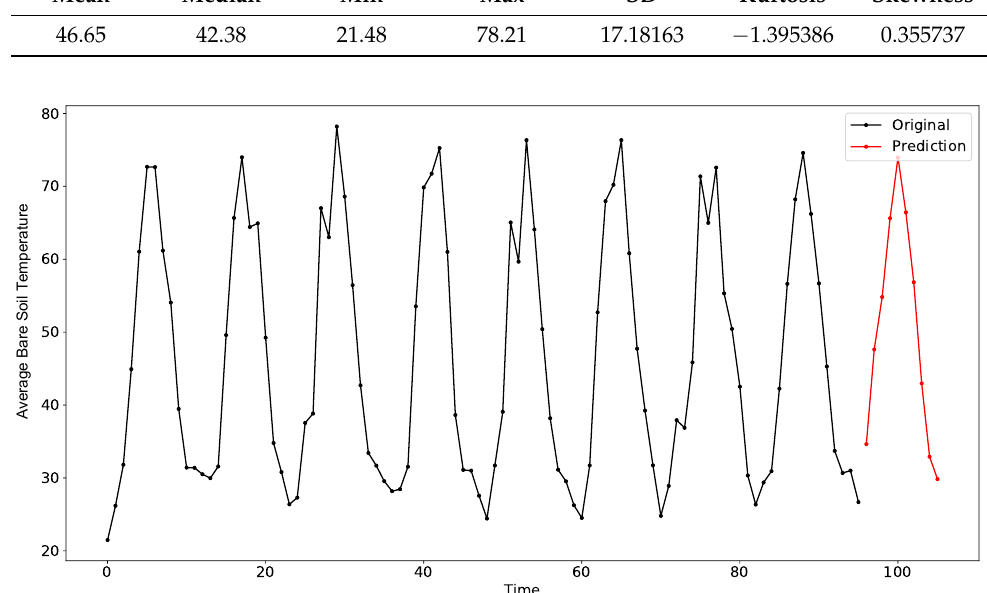
Figure 13. Result of psf_plot() for the “Average Bare Soil Temperature”